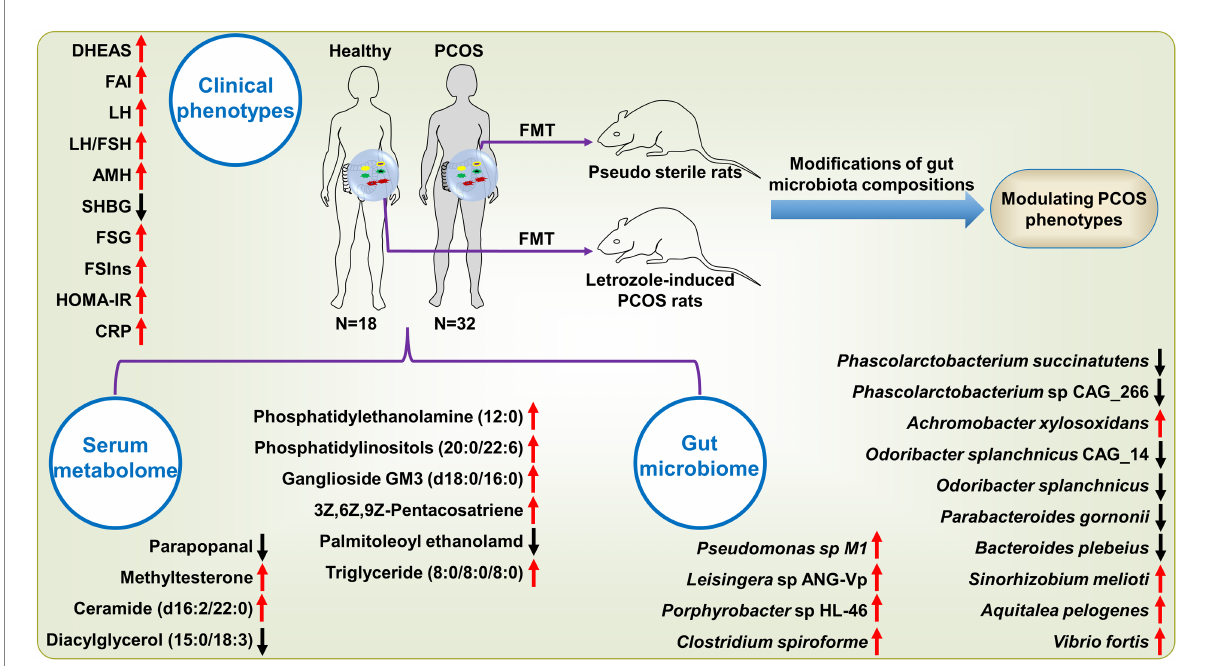
FIGURE 7 The key features in clinical phenotypes, gut microbiome and serum metabolome in PCOS. These variables are shown since they significantly differed between PCOS and healthy subjects and strongly associated with at least three analytes derived from other omics data. The arrow stands for the significant up-regulation or down-regulation of a variable in patients with PCOS as in comparison with healthy subjects. SHBG, sex hormone binding globulin; LH, luteinizing hormone; LH/FSH, the ratio of LH to follicle-stimulating hormone (FSH); AMH, Anti-Mullerian hormone; FSIns, fasting serum insulin; HOMA-IR, homeostasis model assessment of insulin resistance; FSG, fasting serum glucose; CRP, C-reactive protein; DHEAS, dehydroepiandrosterone sulfate; and FAI, free androgen